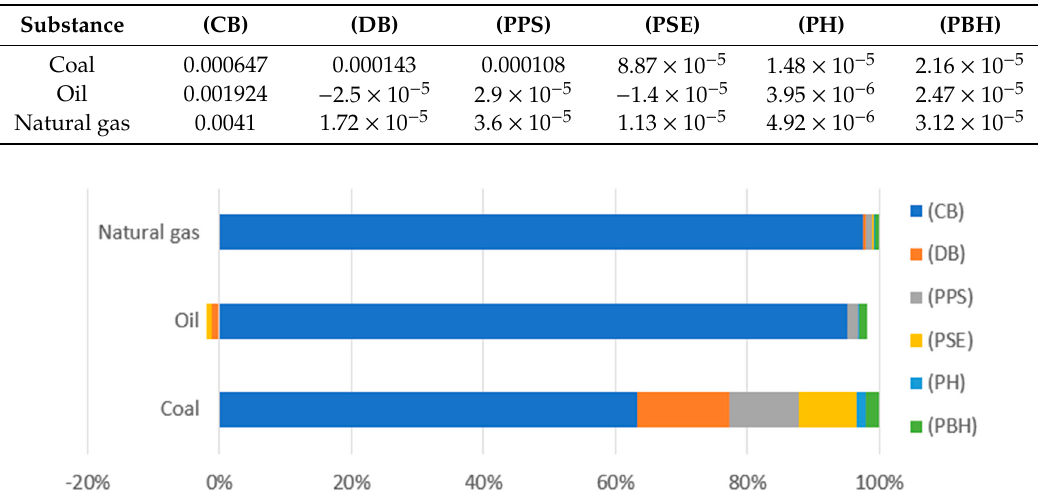
Figure 14. Results of environmental impact characterization for the category of fossil fuel depletion